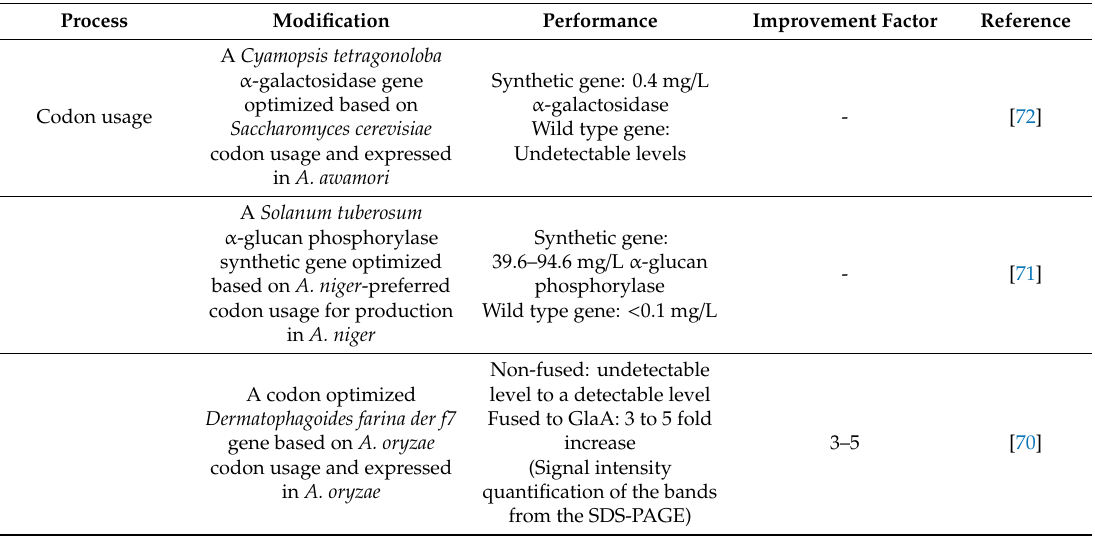
Table 4. Approaches for improving recombinant protein production through codon optimization of the expressed